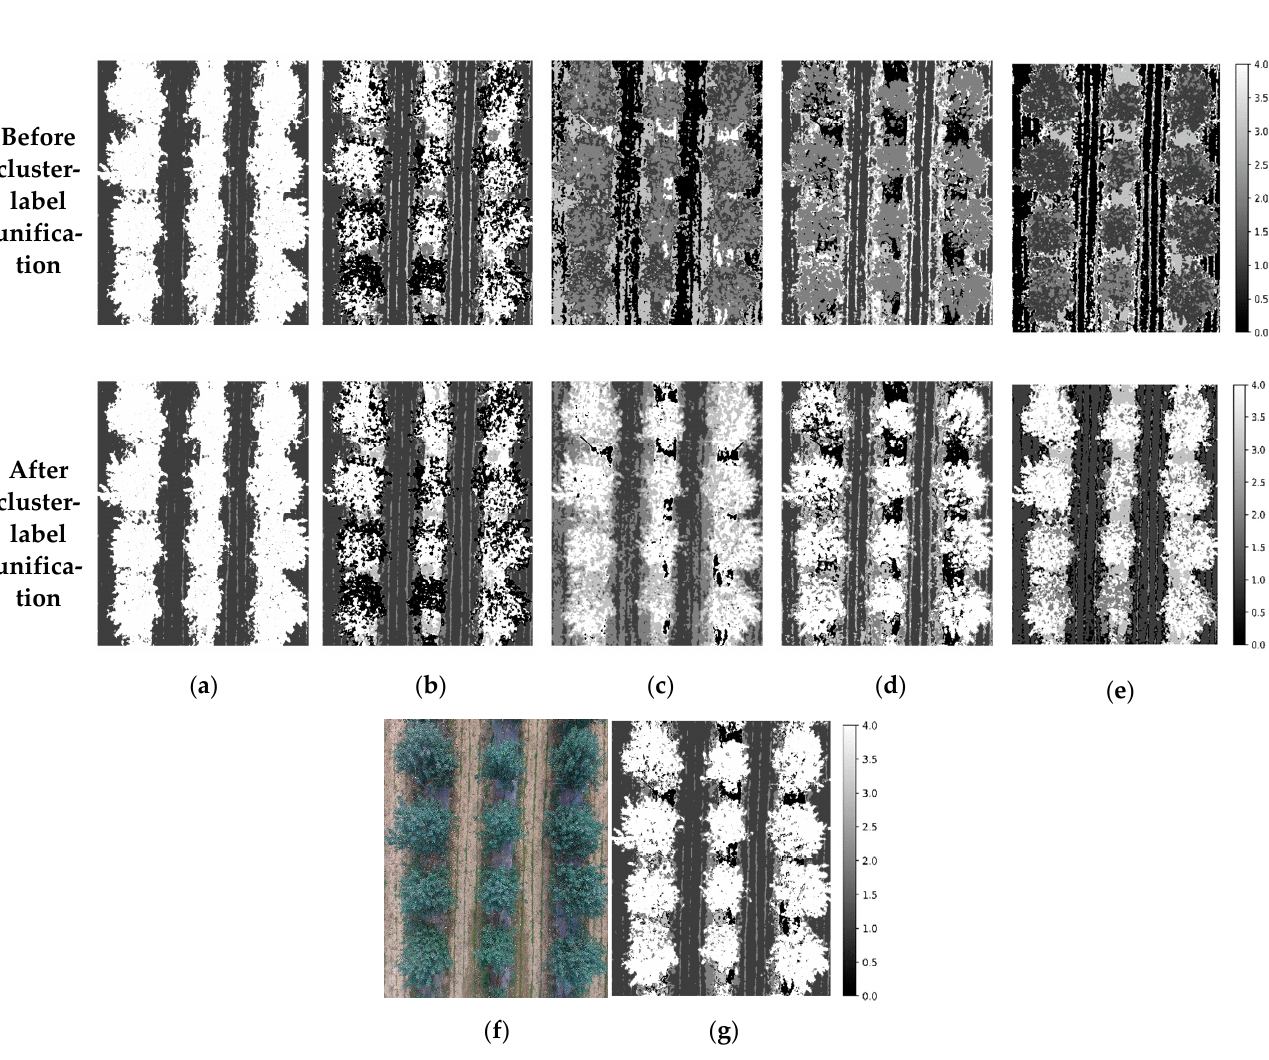
Figure 8. One test image and the result of image segmentation. ( a ) The output of standard k-means; ( b – e ) The output of four Mini Batch K-means whose input from left to right are AOCC, POCC, ROCC, and FOCC. Where AOCC is the color channel with the highest accuracy value, POCC is the color channel with the highest precision value, ROCC is the color channel with the highest recall value, FOCC is the color channel with the highest F1 value, and MOCC is the color channel with the highest mean value of above four indicators. ( f ) Original image; ( g ) the result of combining the partitions using the plurality voting strategy.